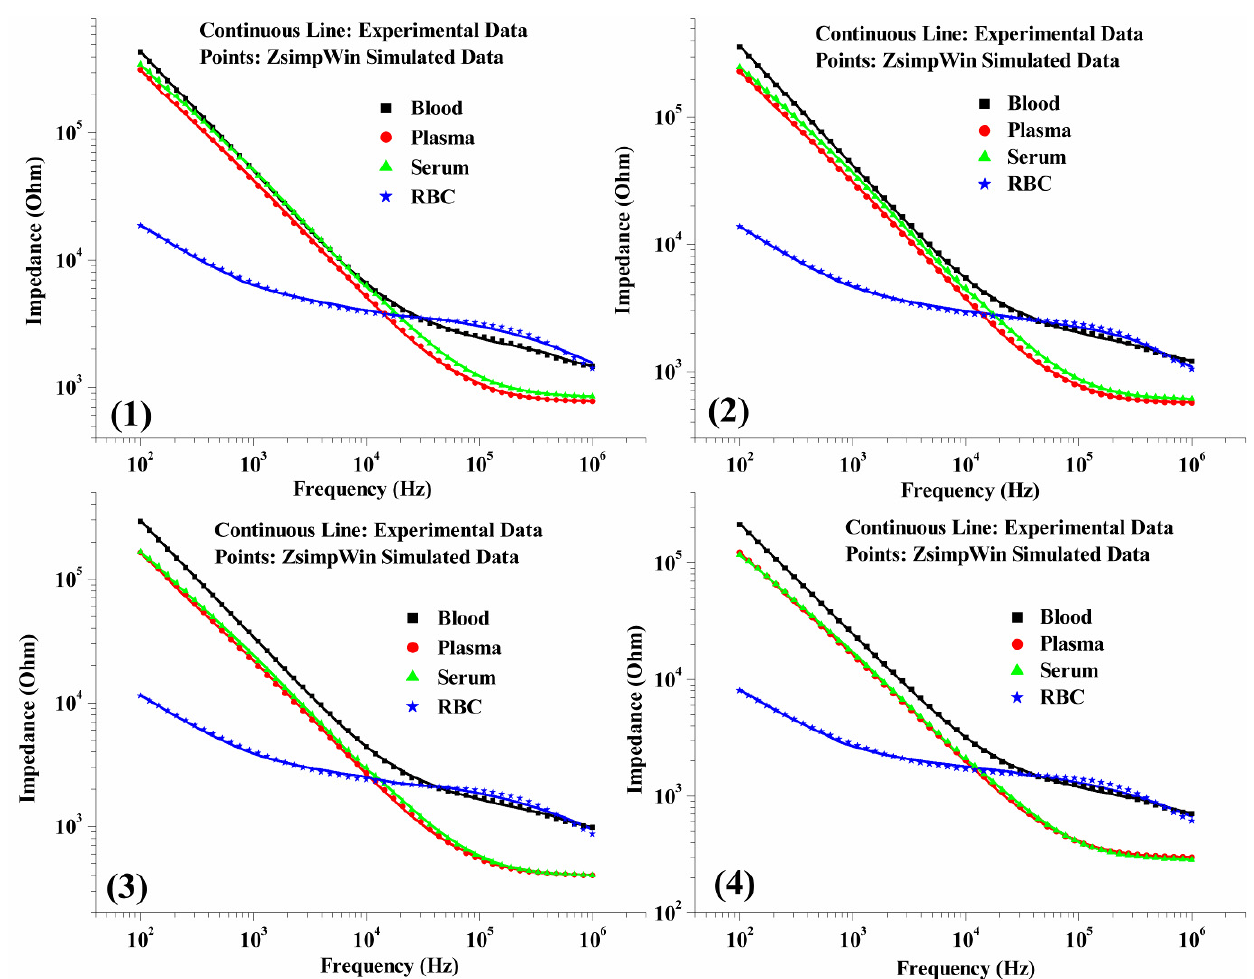
Fig. 7: Bode Plot of blood, serum, plasma, and RBCs for (1) Deign 1; (2) Design 2; (3) Design 3; (4) Design